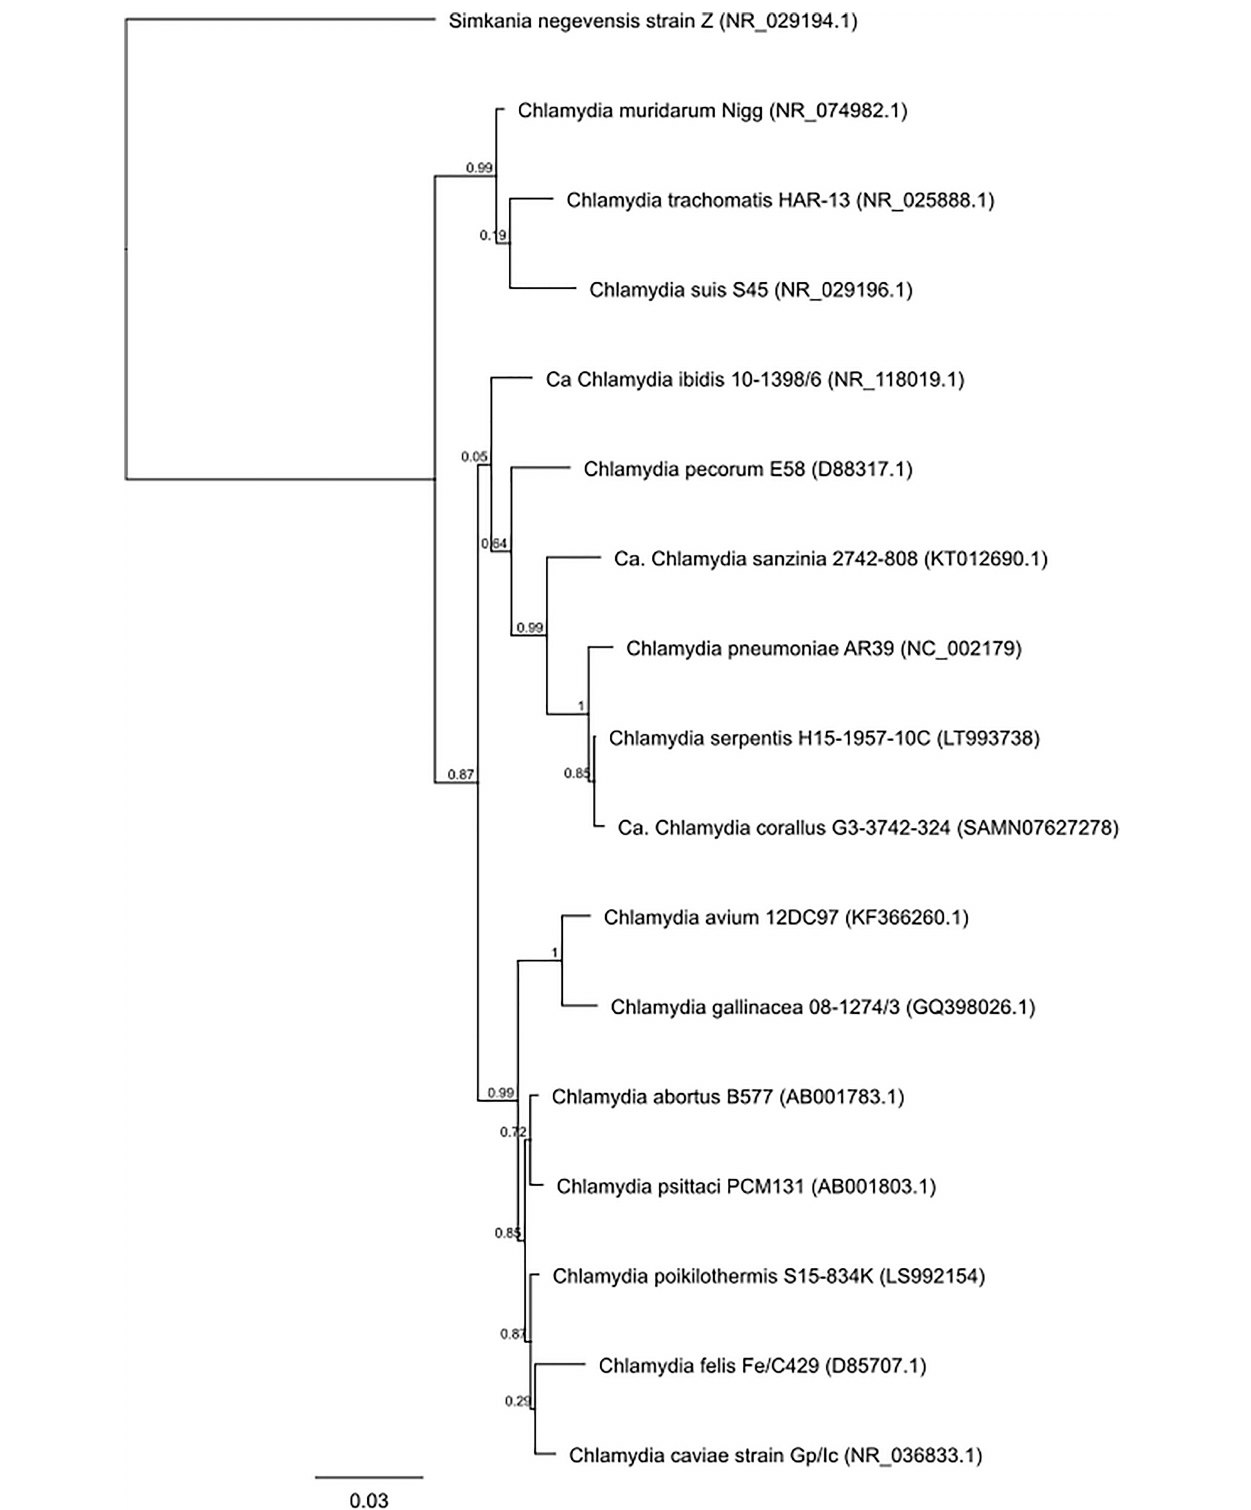
Frontiers in Microbiology |